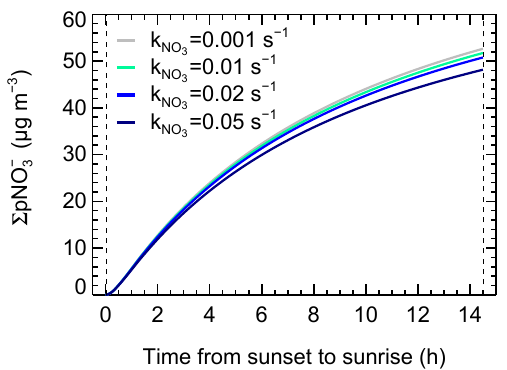
Figure 7. The dependence of overnight NO x loss via N 2 O 5 up- = 0.02s − 1 ) and sensitivity tests of the Figure 8. Base case ( k NO take on γ N in typical winter pollution conditions. The initial 3 2 O 5 integral p NO − formed at 240m via N 2 O 5 uptake at different NO 3 NO 2 and O 3 were set to 60 and 30ppbv, respectively; S a was set to 3 3000µm 2 cm − 3 , the ClNO 2 yield was zero, and k NO was 0.02s − 1 . reactivity (0.001, 0.01, 0.05s − 1 ) on the whole night of 19 Decem- 3 The reaction time was set to 14.5h. The blue and orange zones rep- ber resent the contribution by NO 3 + VOCs and N 2 O 5 uptake, and the dashed line ( γ = 0.002 when N 2 O 5 uptake contributes to 90% of the maximum NO x loss) divides the loss into γ -sensitive and γ - insensitive regions. The maximum nocturnal NO x loss by NO 3 – N 2 O 5 chemistry is 56%.